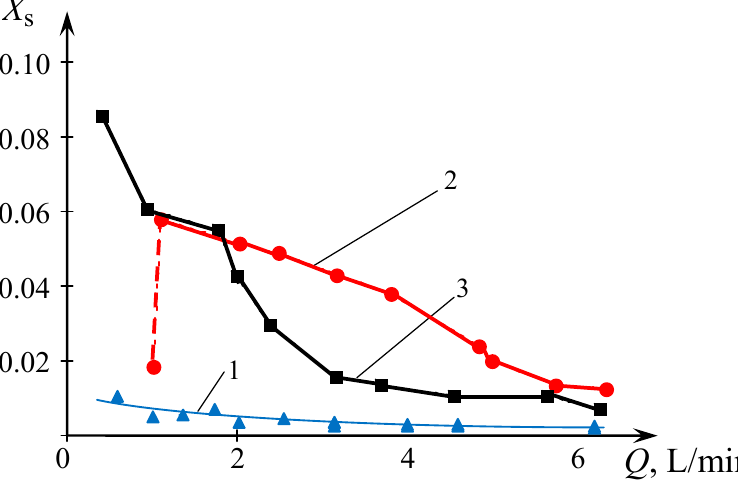
Figure 15. Dependence of the segregation index X s on the total flow rate Q 2 (L/min) for various